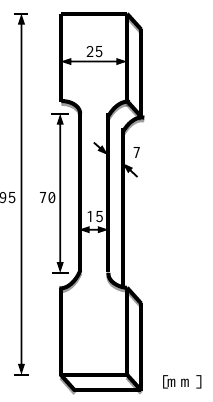
Figure 2. Illustration of specimen for uniaxial tensile test.